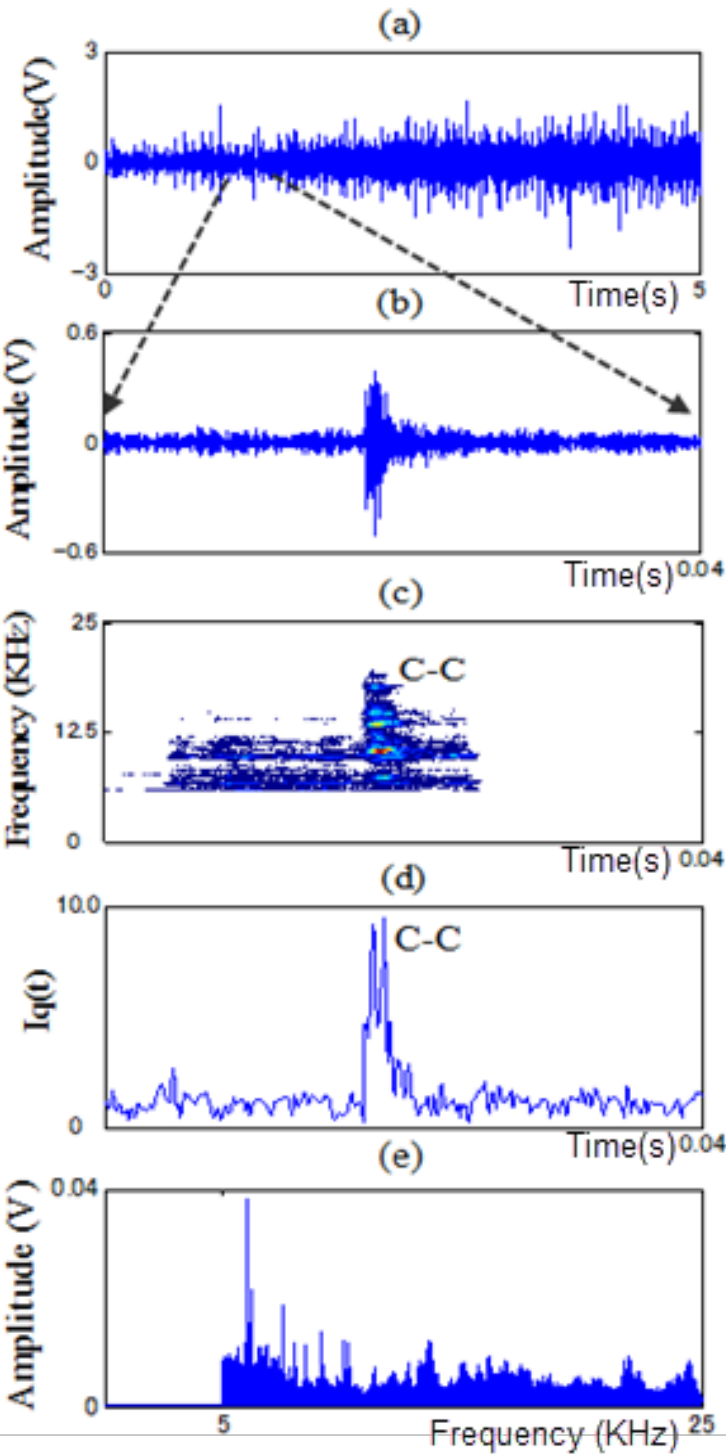
Figure 14. Contour graph and RCI of the spectra in the roller element defect state: ( a ) time signal, ( b ) a part of time signal, ( c ) contour graph, ( d ) RCI, and ( e ) power spectrum at the position